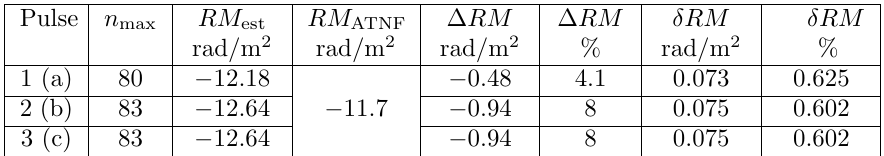
Table 1. The rotation measure of the individual pulses of PSR B0809+74 at the frequency F c = 23.7 MHz.